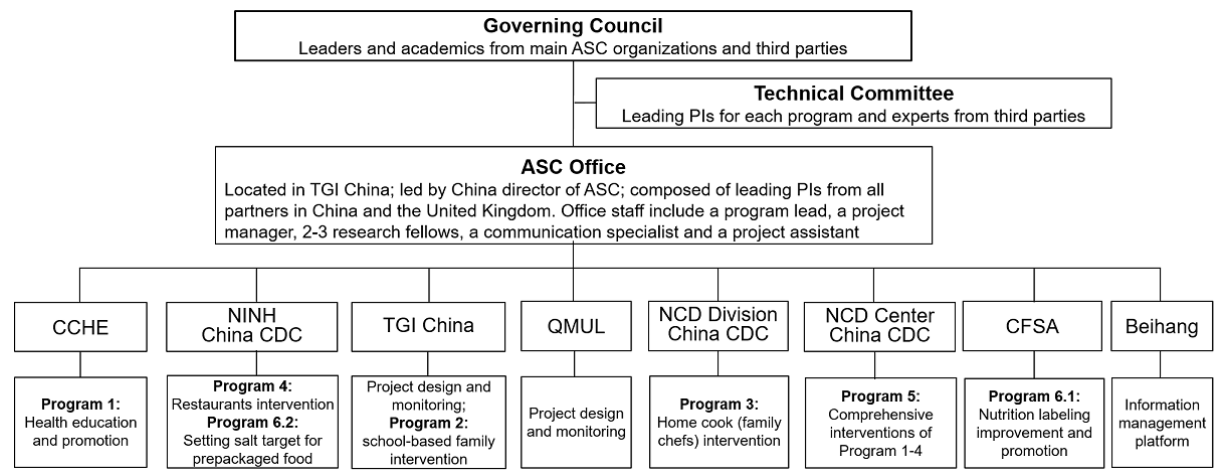
Figure 1. Governance and specific programs of Action on Salt China (ASC) program. PI: principal investigator; China CDC: China Centers for Disease Control; CCHE: Chinese Center for Health Education; NINH: National Institute for Nutrition and Health, China CDC; TGI China: The George Institute for Global Health China; QMUL: Queen Mary University of London; NCD Division: Division of NCD Control and Community Health, China CDC; NCD Center: National Center for Chronic and Non-communicable Disease Control and Prevention, China CDC; CFSA: China National Center for Food Safety Risk Assessment; Beihang: Beihang University (Or Beijing University of Aeronautics and